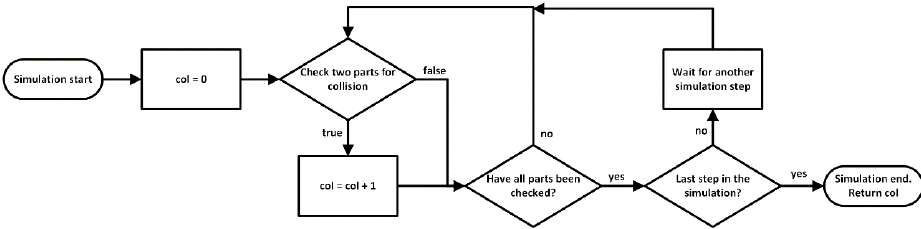
Figure 7. Flowchart of the collision calculation.